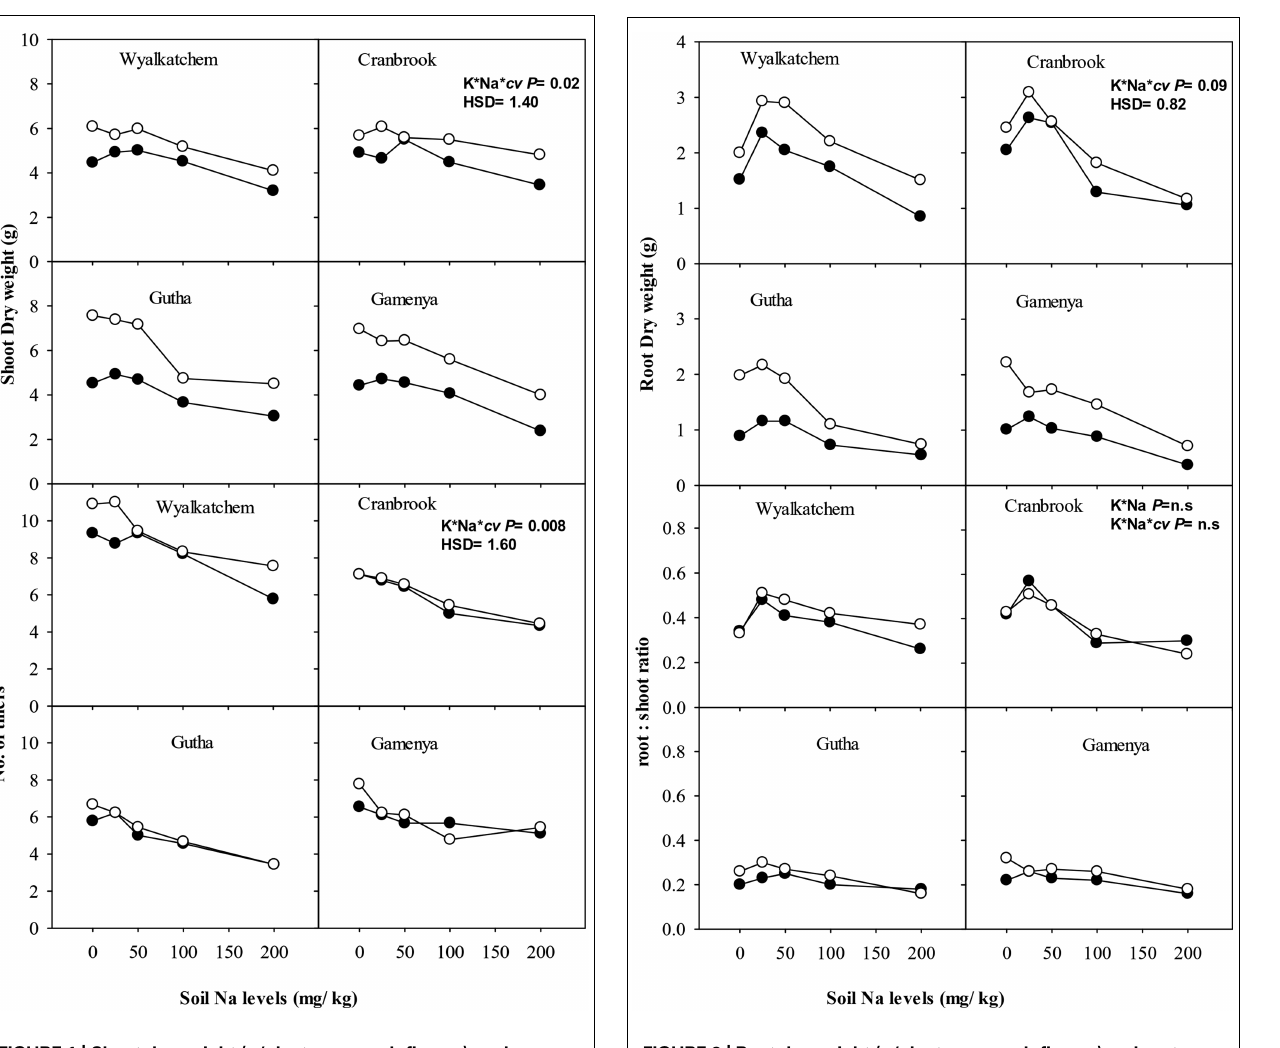
FIGURE 2 | Root dry weight (g/plant; upper sub-figures) and root: shoot ratio (lower sub-figures; n = 3) of four wheat cultivars, treated Table 1 for analysis of variance